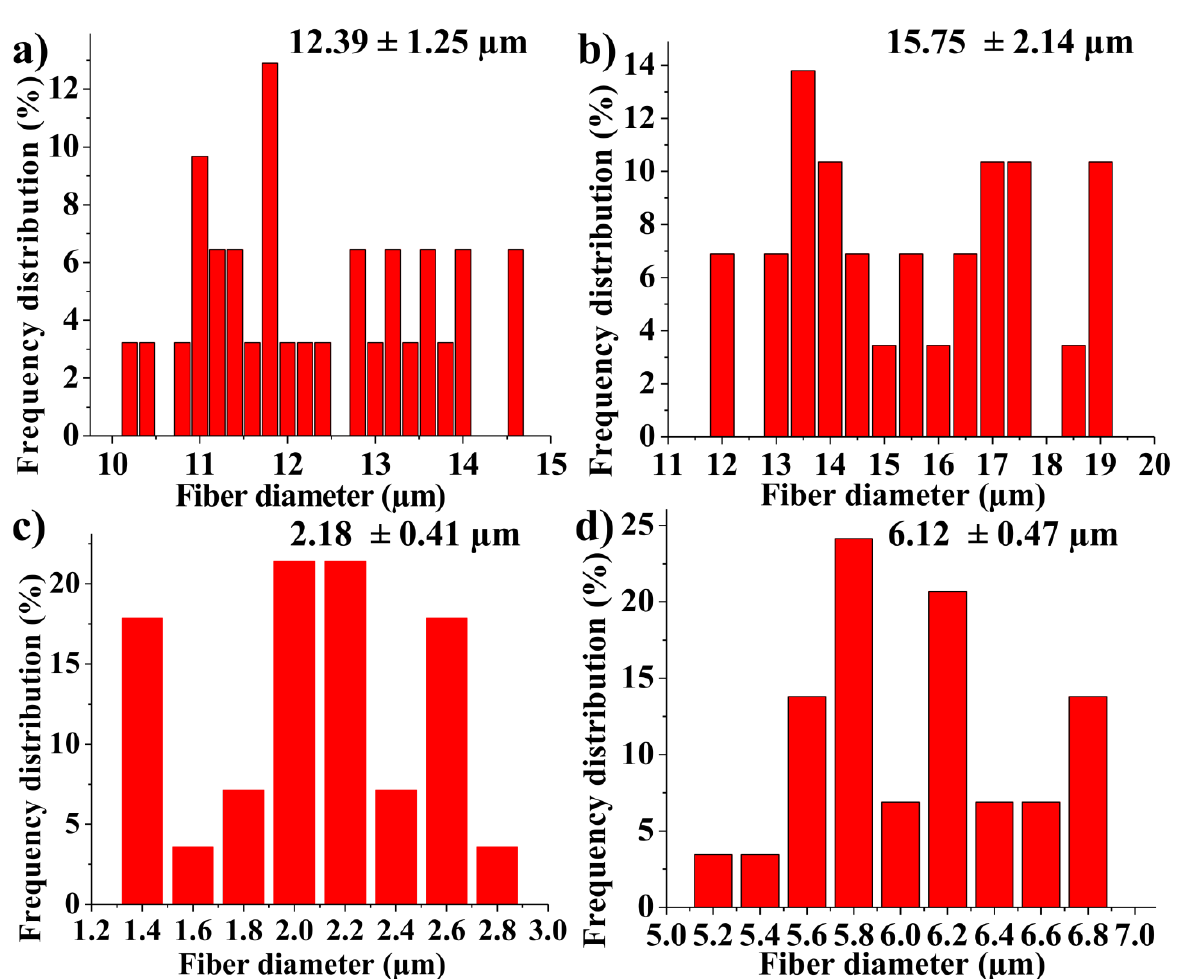
Figure 5. Fiber diameter frequency distributions from SEM images: ( a ) PCL, ( b ) PCL-5% nHAP, ( c ) PCL-20% MET and ( d ) PCL-5% nHAP-20% MET.